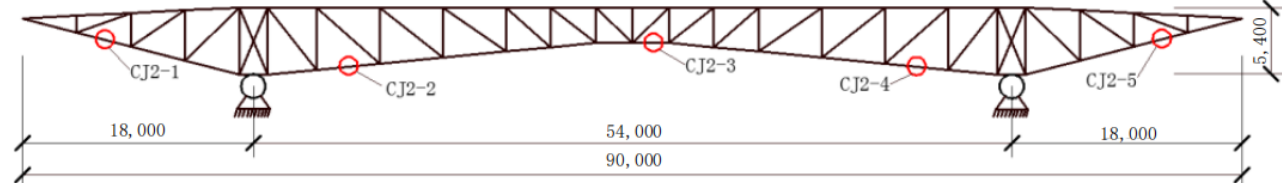
Figure 13. Arrangement of deformation monitoring points.